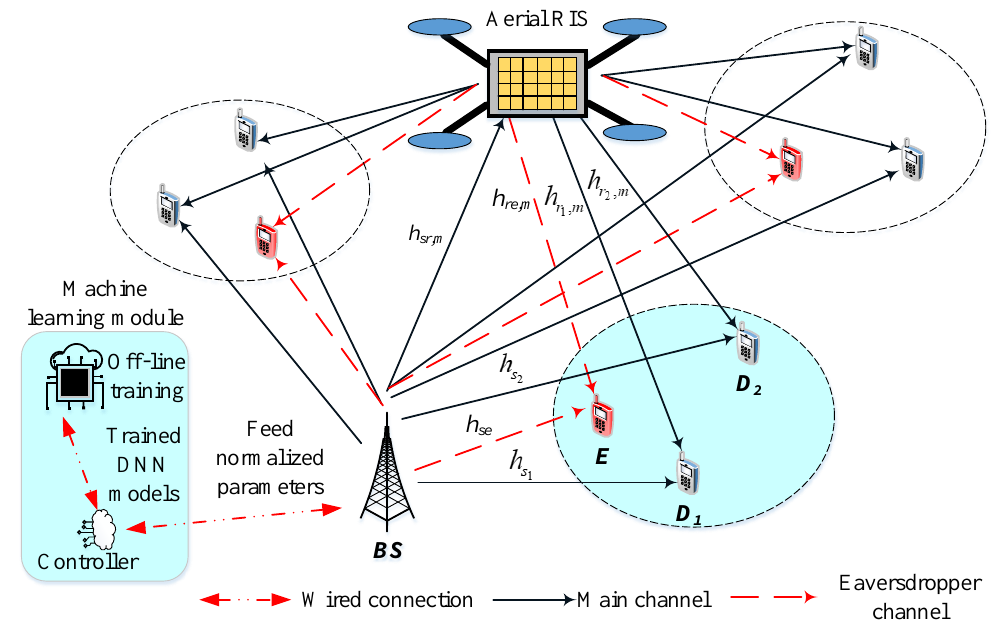
Figure 1. A model of DNN-based RIS-NOMA